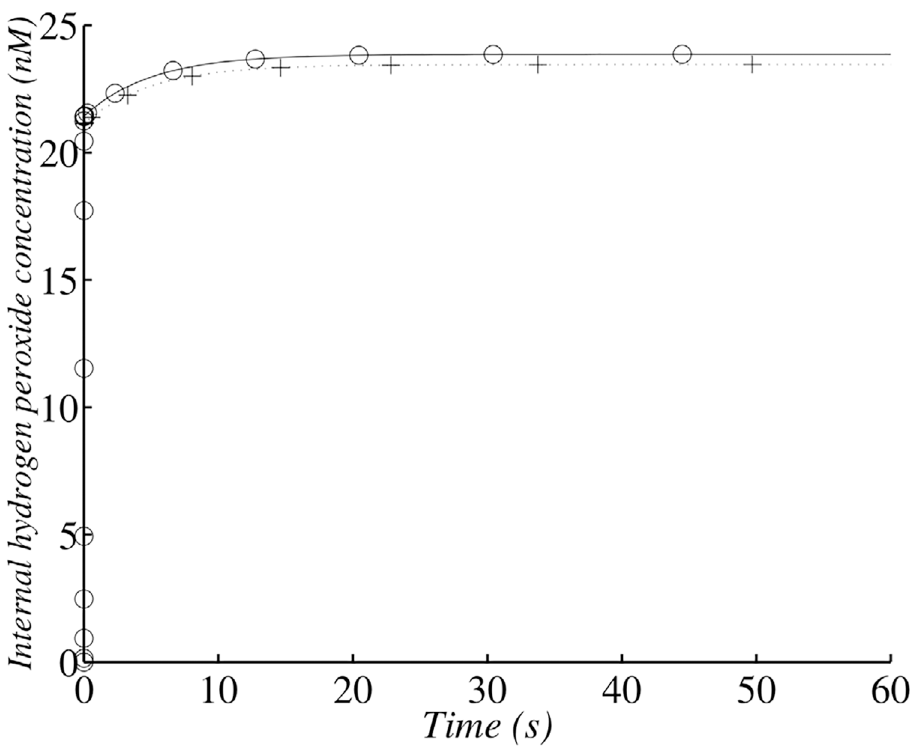
Fig 3. Changes in H 2 O 2 concentration in the wild-type strain with 10 9 cells ml − 1 . (+) corresponds to the analytical solution according to the simplified system and ( (cid:10) )) corresponds to the whole model and a numerical